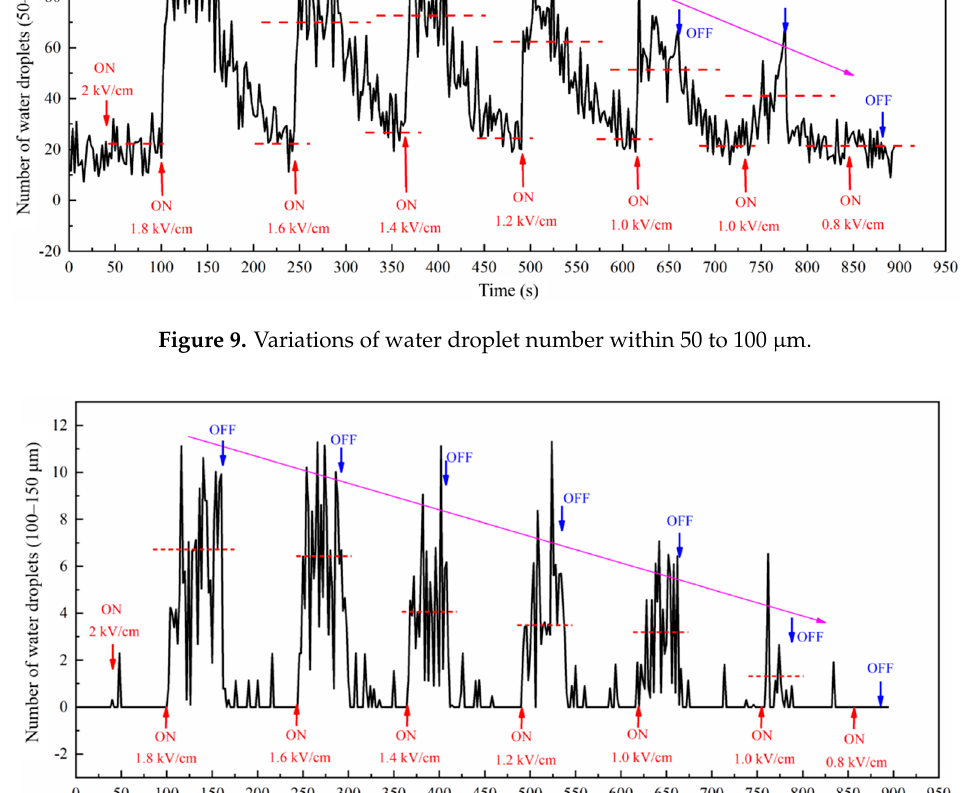
Figure 10. Variations of water droplets number within 100 to 150 µ m.